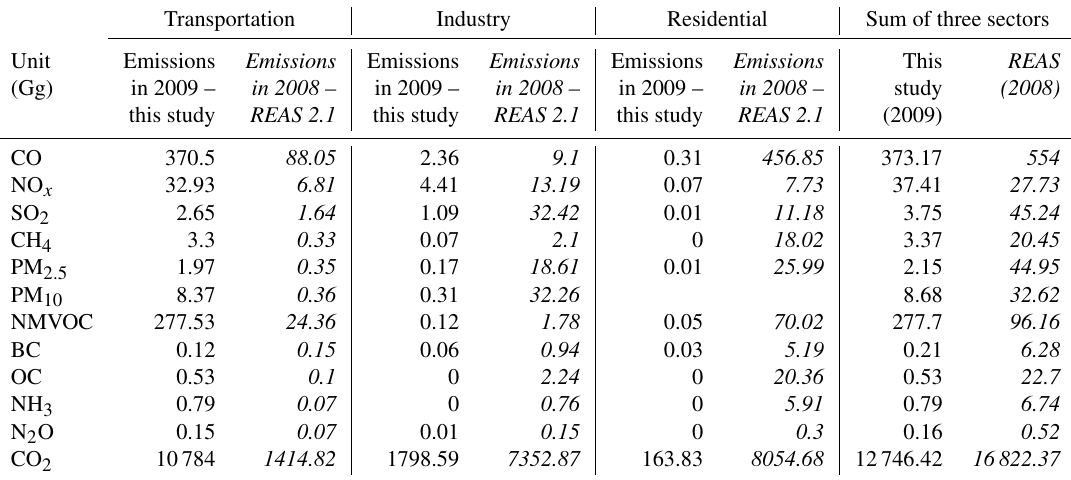
Table 15. Comparison of transportation, industry and domestic emissions estimated for 2009 in this study and emissions estimated by REAS 2.1 for 2008. Italic numbers refer to emissions provided by REAS 2.1.